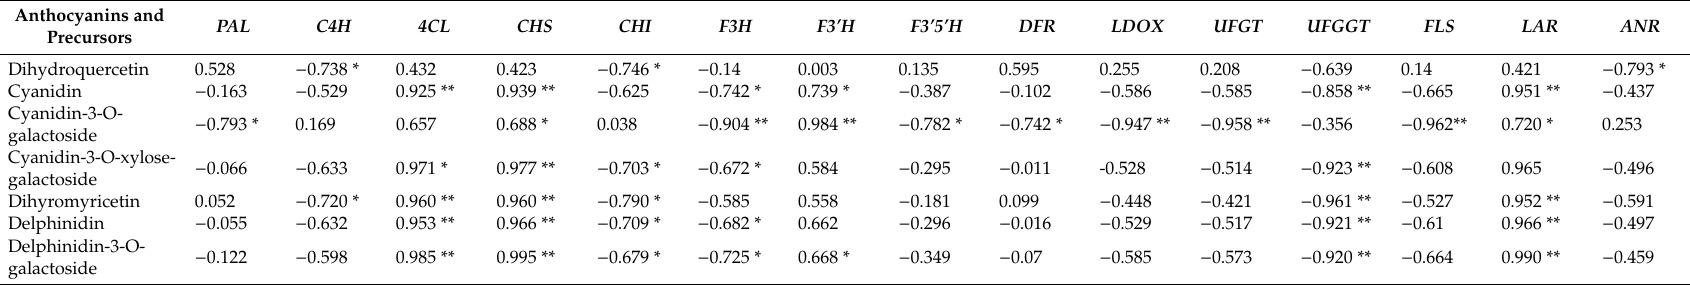
− 0.122 ‘*’ indicates correlation is significant at the 0.05 level (2-tailed); ‘**’ indicates correlation is significant at the 0.01 level (2-tailed). The gray shadow mark represents the expression level of candidate gene CHS is significantly correlated to 6 anthocyanins at 0.05 and 0.01